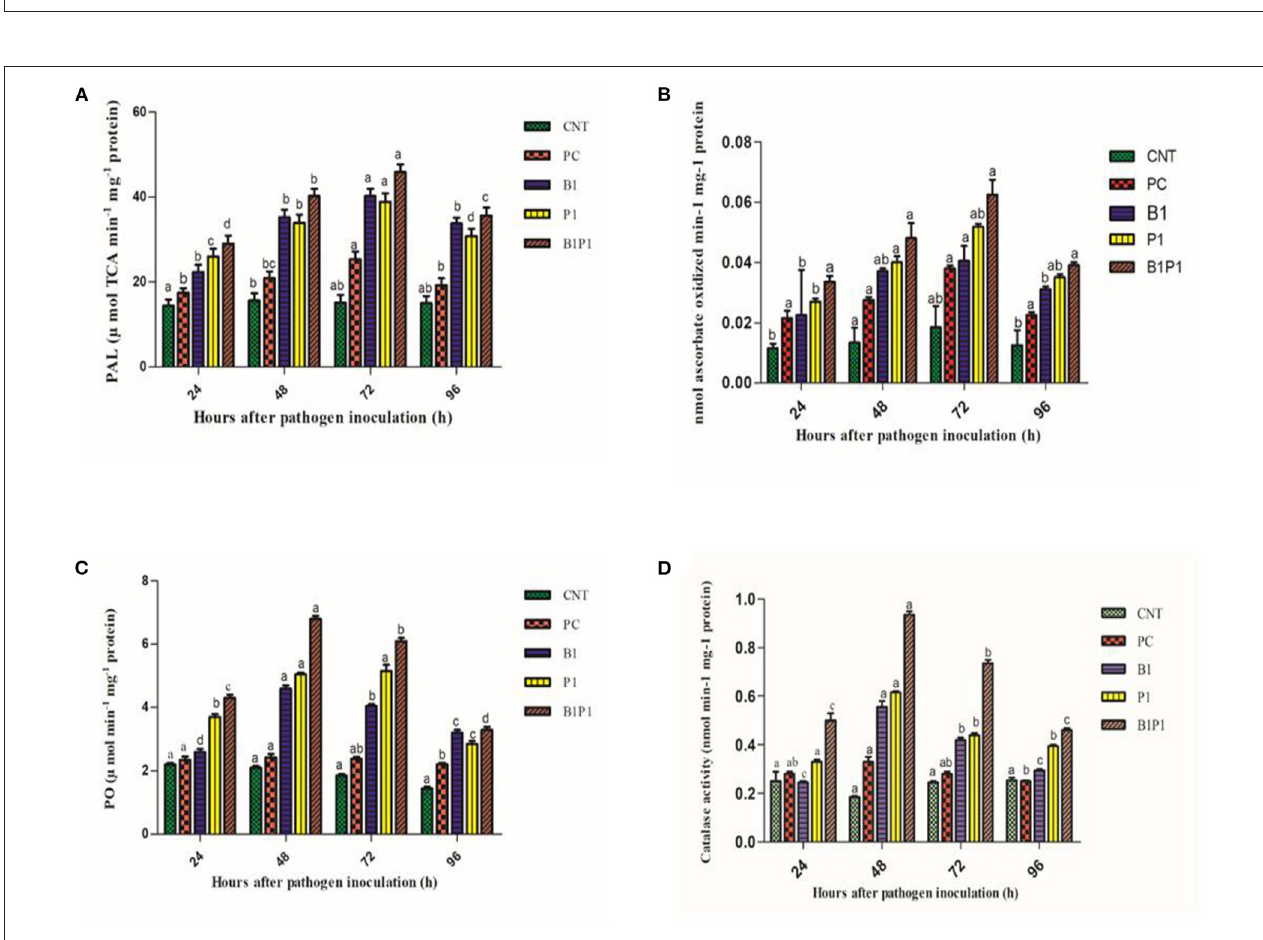
FIGURE 12 | Enzymatic activity [PAL, (A) ; APX, (B) ; PO, (C) ; CAT, (D) ] of tomato leaves treated with different treatments of 24 h − 96h of pathogen inoculation. Data are shown as a mean ± SE ( n = 3). Tukey’s B post-hoc test at 5% confidence level ( p < 0.05) was used to test the significance of the data. These alphabets denoted the different significant